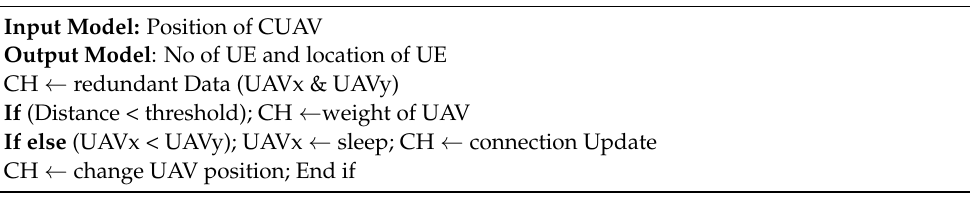
Figure 4. Redundant Flow Diagram. Algorithm 3: Redundant Drone Algorithm